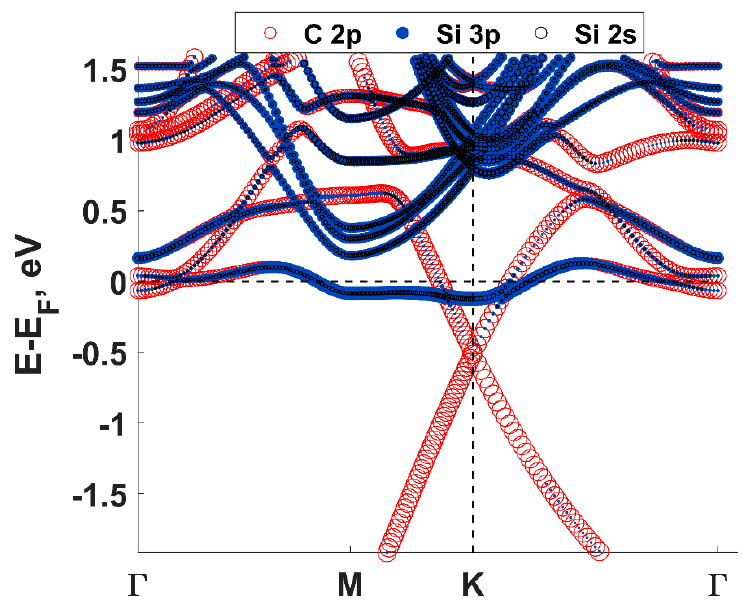
Figure 3. Fat band structure (calculated in the frames of the current work) for monolayer epitaxial graphene on 4H-SiC, including contributions of key orbitals to the bands. The size of each circle is proportional to the corresponding orbital contribution to each band. The Fermi level was set to 0 eV. The band-structure calculations were performed using 32 × 32 × 1 k-point Monkhorst-Pack mesh at vdW/BH/DZP level of DFT by SIESTA code.